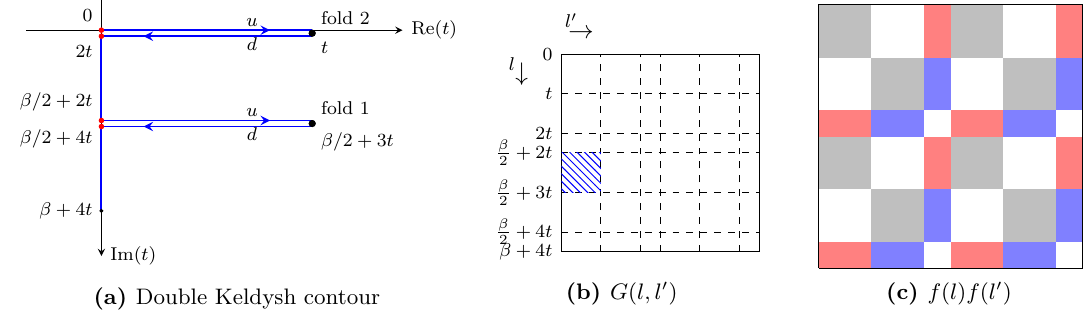
Figure 5. (a) The double Keldysh contour used in the numerics is shown in blue; the red dots represent the insertion of sources. (b) The coordinate system for the Green function G ( l, l 0 ) . The part that we use, W ( t 1 , t 2 ) , corresponds to the hatched area. (c) The function f ( l ) f ( l 0 ) , where the white, gray, red, and blue colors represent 1 , − 1 , i , and − i ,